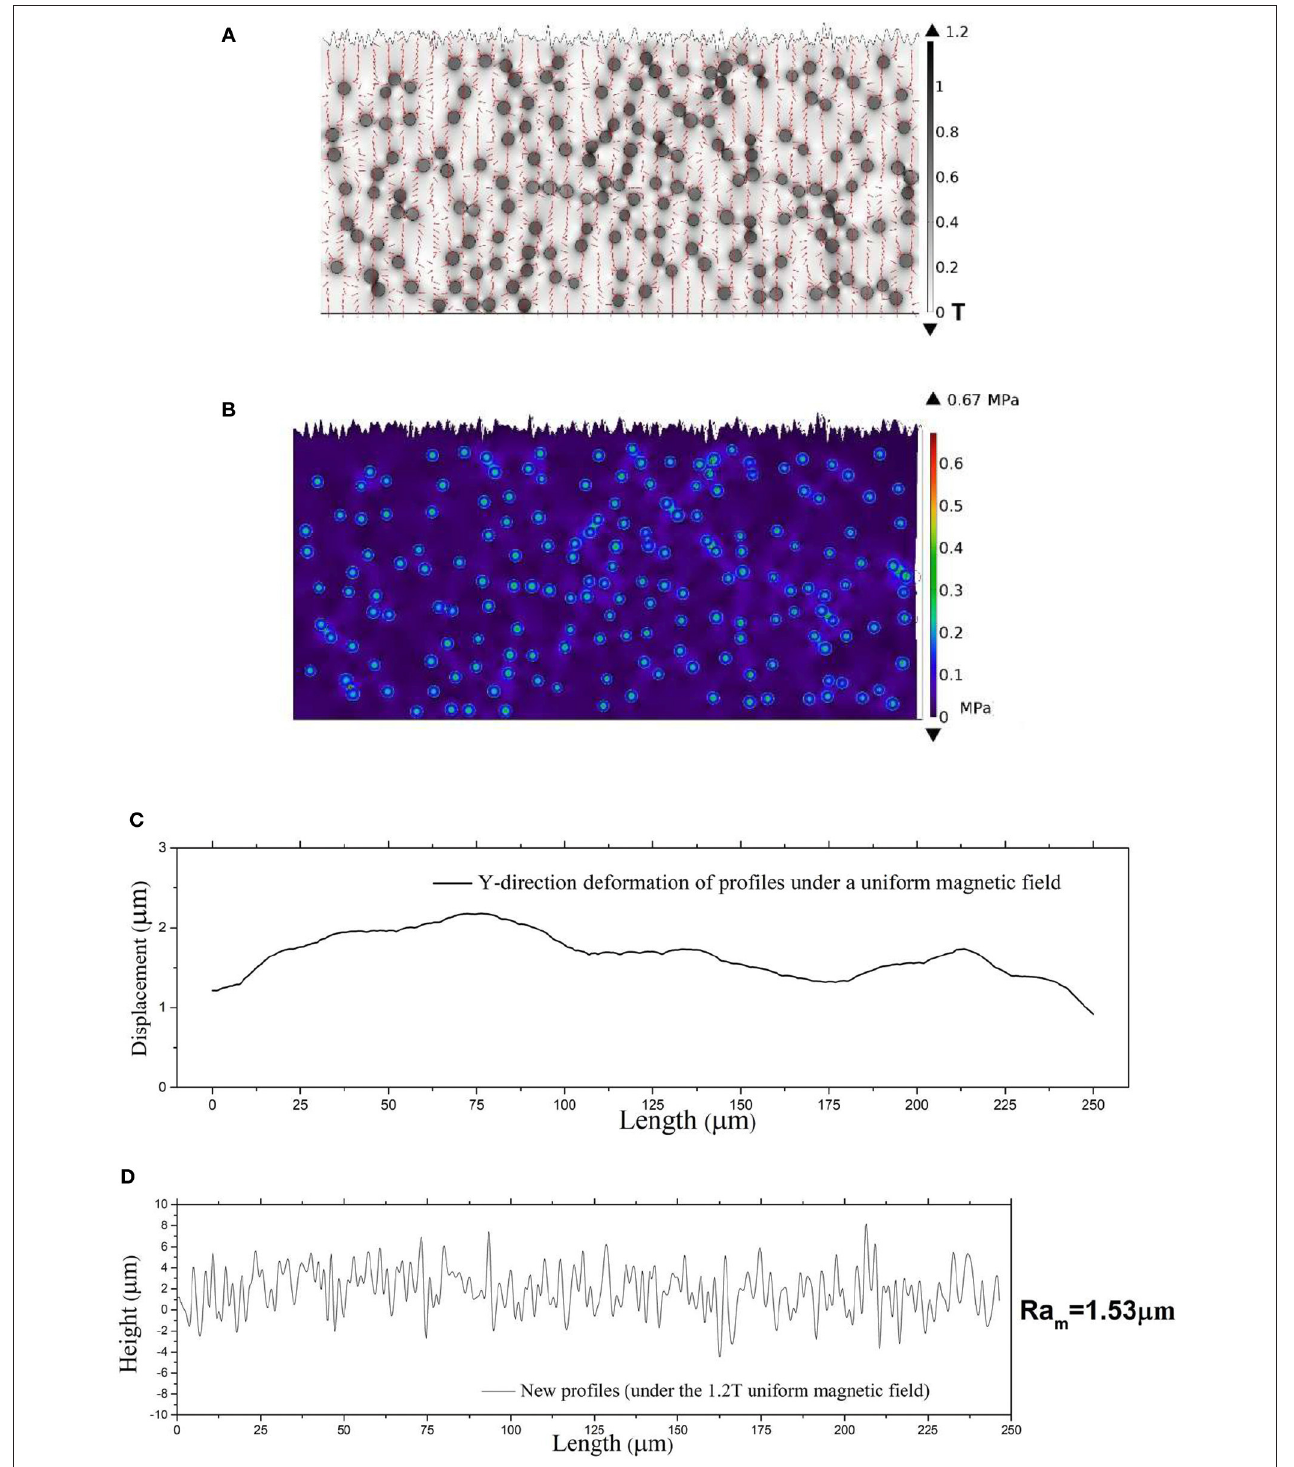
FIGURE 2 | Simulation results with proposed model (A) Magnetic flux density distribution. (B) Stress field. (C) Magnetic induced displacements of the surface profile in Y-direction. (D) The new surface profile after the magnetization of 1,000 KA/m is applied on. And the roughness of the surface is 1.53 µ m.